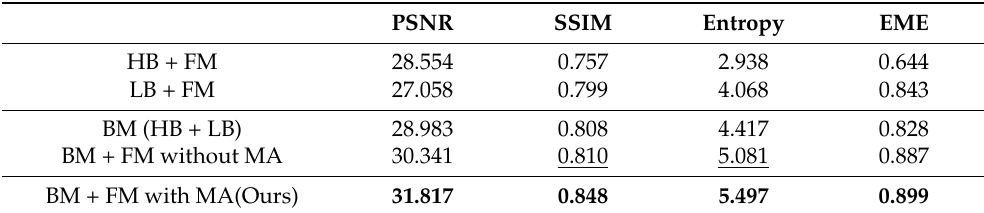
Table 3. Numerical analysis of different structures. The highest and second-highest scores are marked in bold and underlined